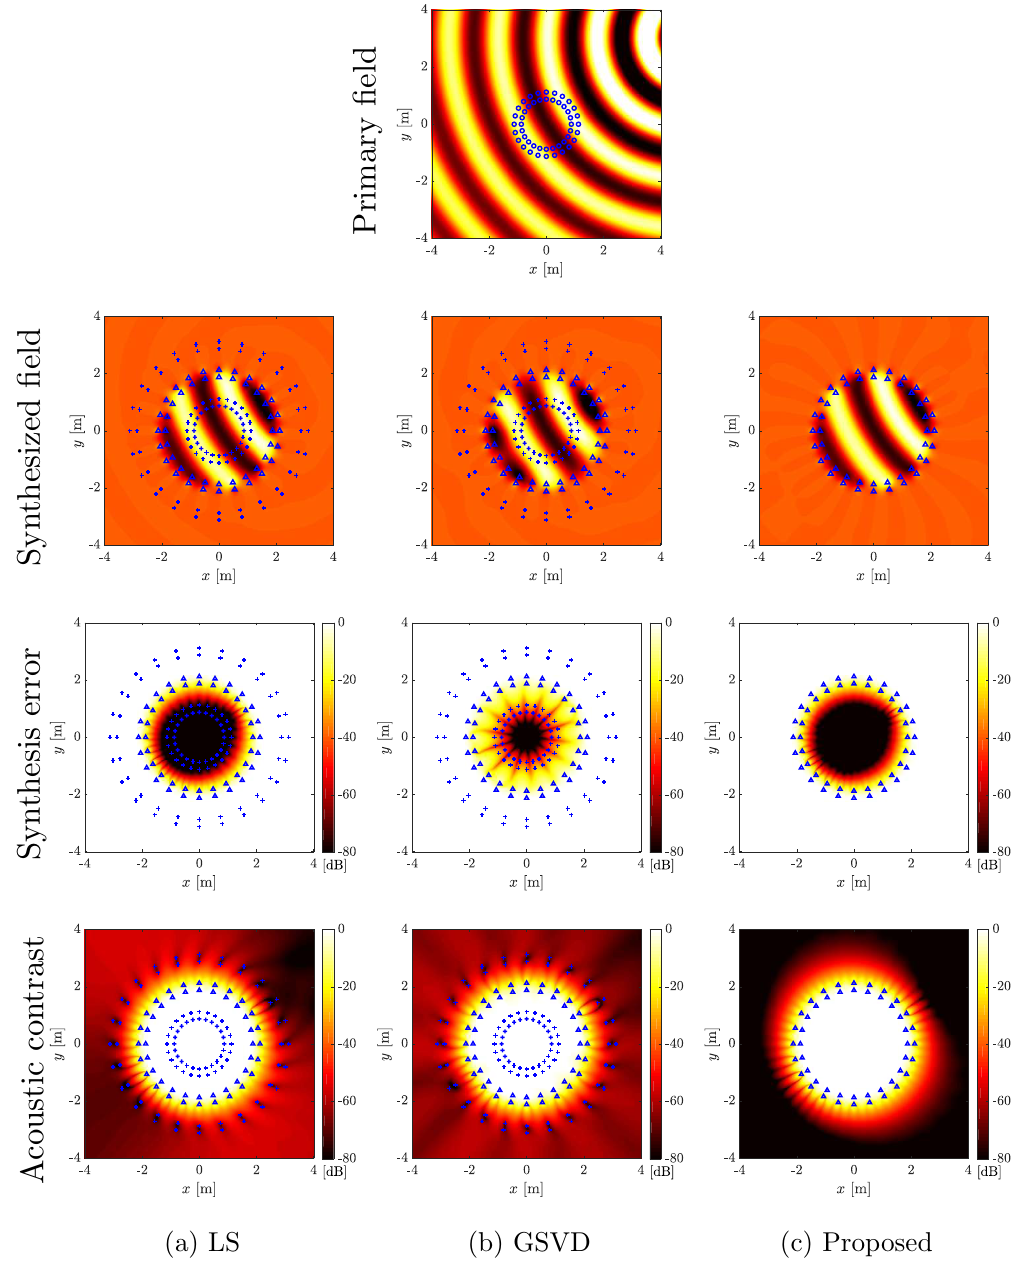
Figure 6. Results of primary sound field, synthesized sound field, interior sound field synthesis accuracy and exterior acoustic contrast by LS, GSDV, and proposed mode-matching methods with ∆ = 0.25 m in free-field condition for f = 200 Hz. Blue ◦ , (cid:52) and + are microphones, loudspeakers and control points,